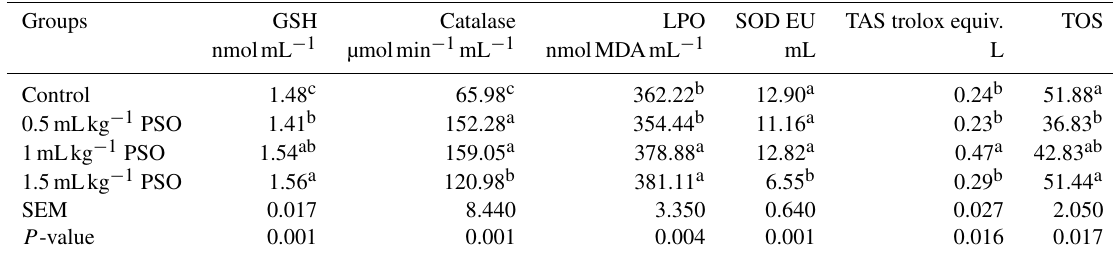
Table 6. Effects of PSO on some antioxidant enzymes in the serum of the laying hens. Groups GSH Catalase LPO Control